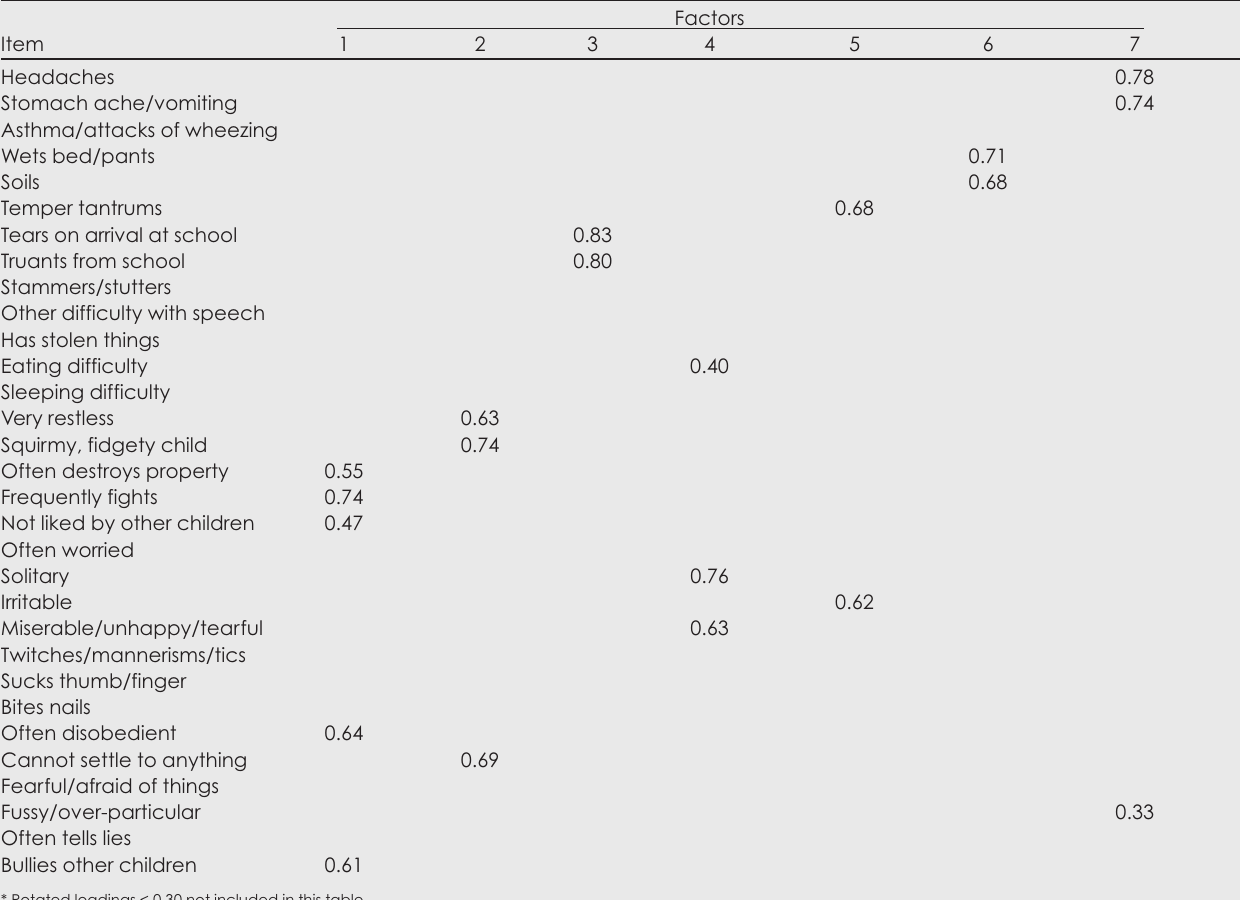
Table I. The Rutter Scale A2 — results of principal factor analysis followed by Varimax